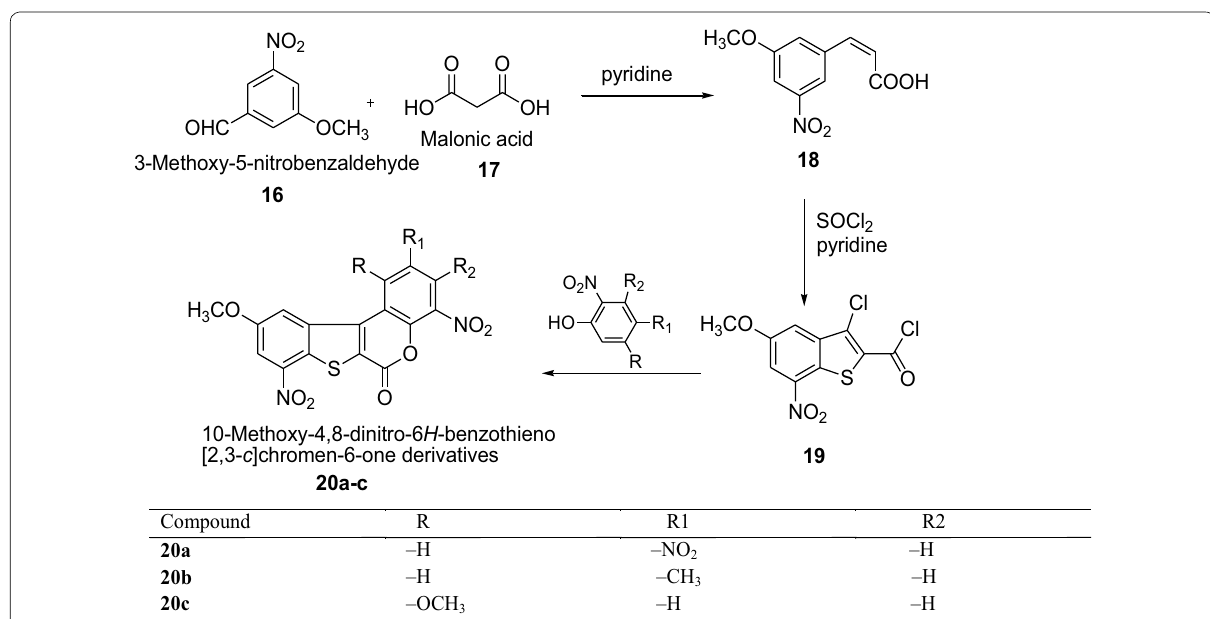
Table 5 Antimicrobial activity of benzothienopyrimidinone derivatives Compd S.